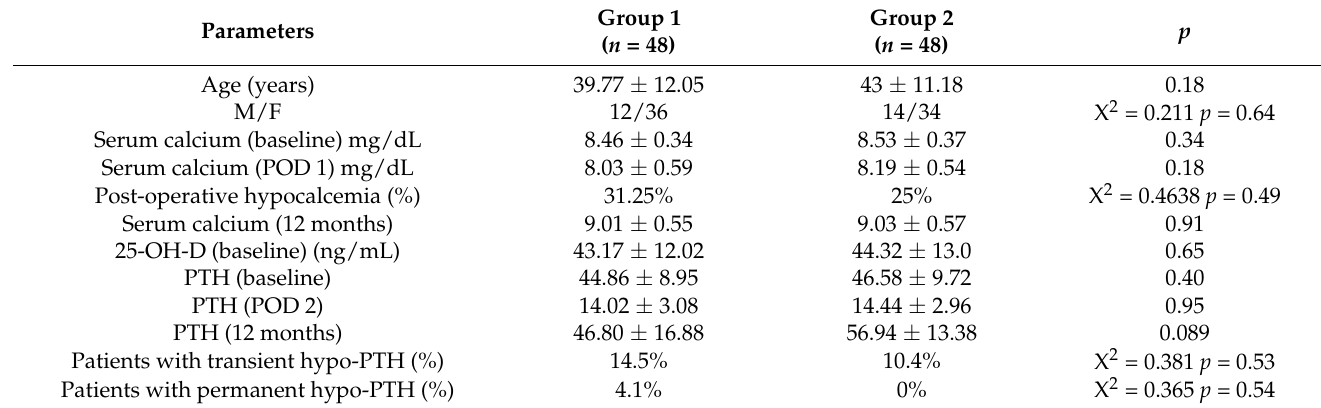
Table 1. Anthropometric, perioperative, biochemical, and pathologic features of subjects with previous history of restrictive bariatric surgery (LSG + GB) (Group 1) and without (Group